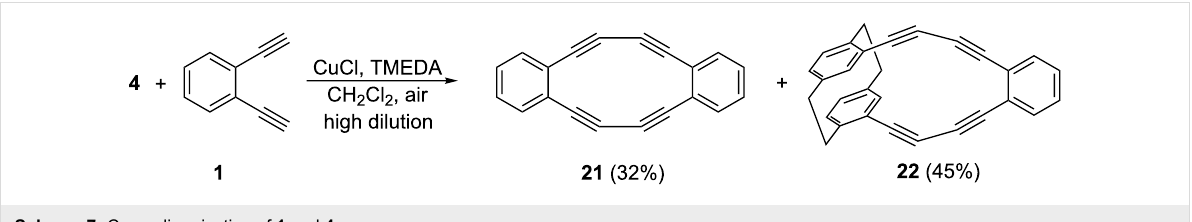
Scheme 7: Cross dimerization of 1 and 4 .